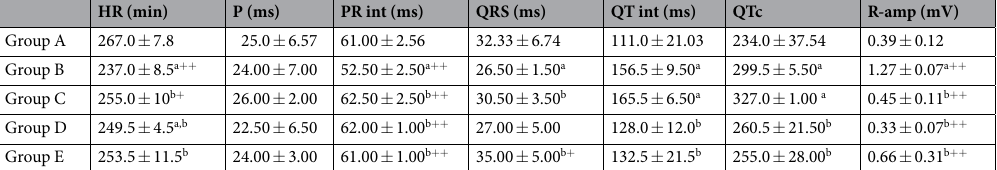
Table 1. Effect of pretreatment of CurNisNp on heart rate and ECG parameters in MI induced guinea pigs. Note; HR, heart rate; P, PR, QRS and QT are durations on the ECG wave form; QTc, corrected QT interval; R-amp, R-wave amplitude. The results in the table above are in Mean ± standard deviation of each group of five guinea pigs. a P < 0.05 compared with group A; a ++ P < 0.001 compared with group A; b P < 0.05 compared with group B; b + P < 0.01 compared with group B; b ++ P < 0.001 compared with group B.